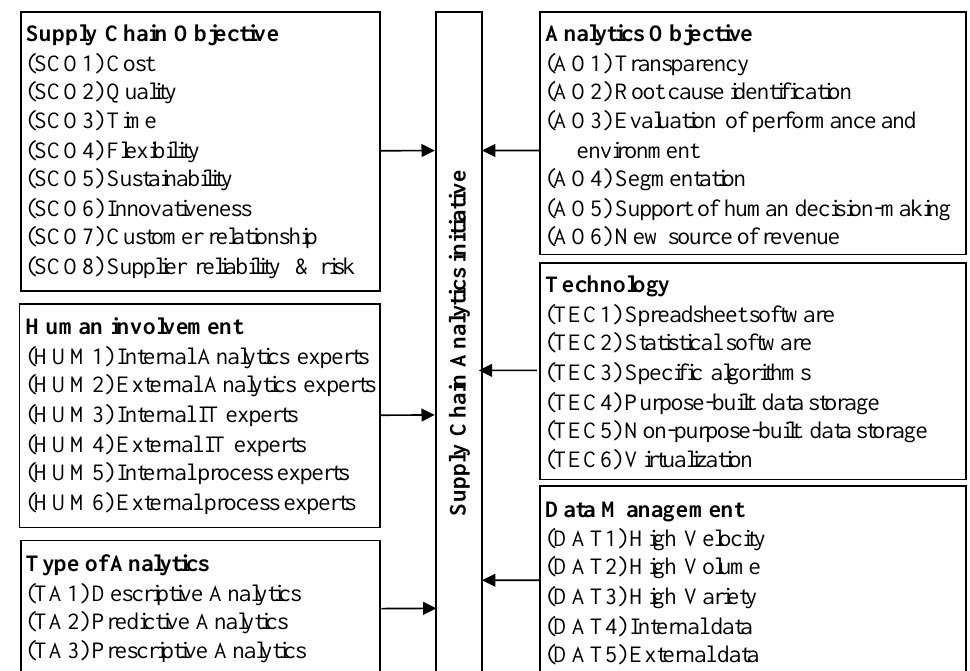
Figure 1. Characteristics of a Supply Chain Analytics initiative.